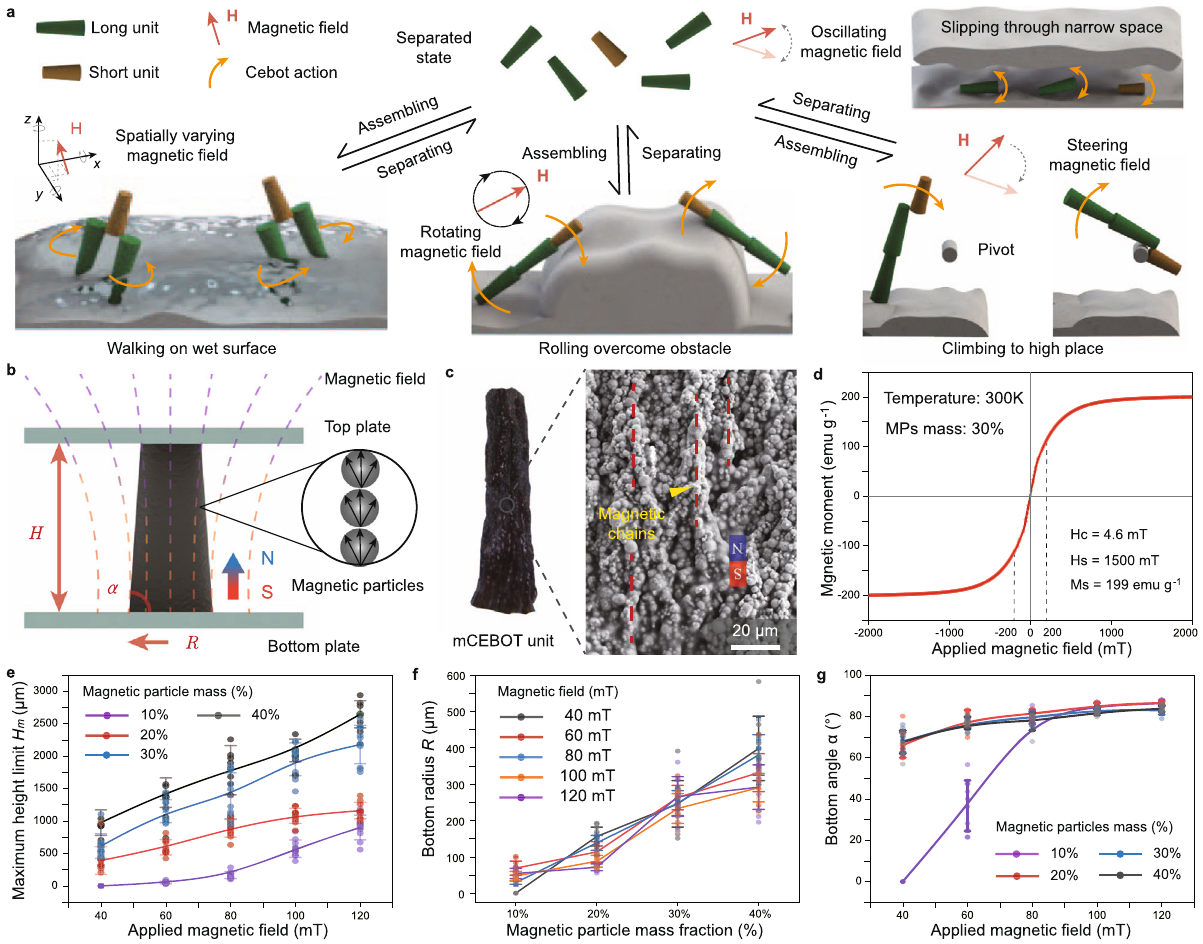
Fig. 1 Design, fabrication and characterization of mCEBOT units. a Schematic of mCEBOT which can recon fi gure architectures and functions according to the unstructured environment and tasks. b Magnetic- fi eld-assisted fabrication for mCEBOT units. c Surface texture of mCEBOT unit under SEM. d Magnetic susceptibility of mCEBOT unit under the magnetic fi eld from − 2000 to 2000 mT. e The relationship between unit ’ s maximum height and applied magnetic fi eld with different magnetic particle mass from 10 to 40%. f Bottom width of unit corresponding to various magnetic particle mass from 10 to 40% under magnetic fi eld from 40 to 120 mT. g The relationship between unit ’ s bottom angle and applied magnetic fi eld with different magnetic particle mass from 10 to 40%. Error bars indicate the standard deviation for n = 10 measurements at each data